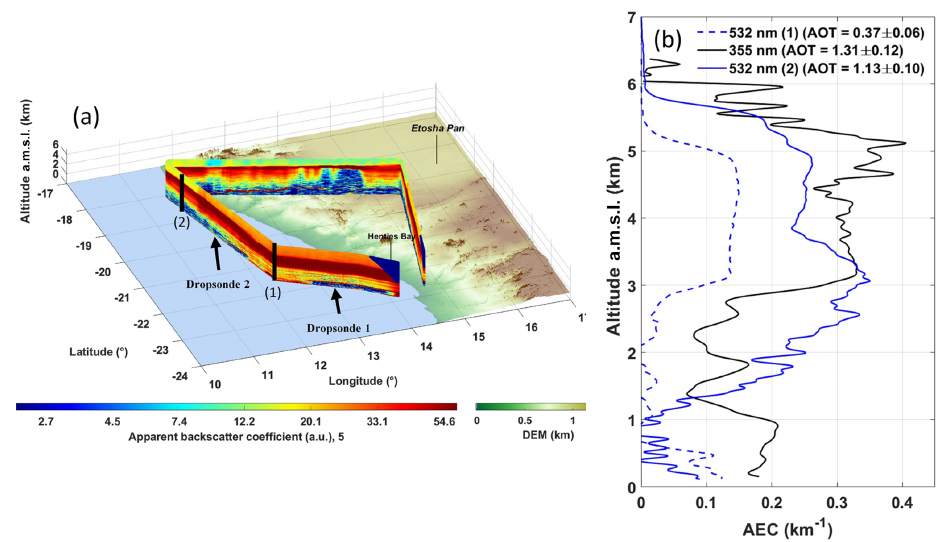
Figure 10. (a) Same as Fig. 6a but on 6 September 2017. The locations of the two launched dropsondes are also indicated by arrows. The lidar AEC profile labelled “1” shown in panel (b) is obtained after inversion of the LNG observations averaged between the two locations of the two dropsondes. The AEC profile labelled “2” is obtained after inversion of the lidar data between the northernmost dropsonde and the northern end of the Falcon leg. (b) Vertical profiles of the AEC derived from the airborne lidar at 532nm ( ∼ 08:30 and ∼ 09:00UTC, for profile “2” (solid blue line) and “1” (dashed blue line), respectively) and from the ground-based lidar at 355nm ( ∼ 07:00–09:30UTC; solid black line).